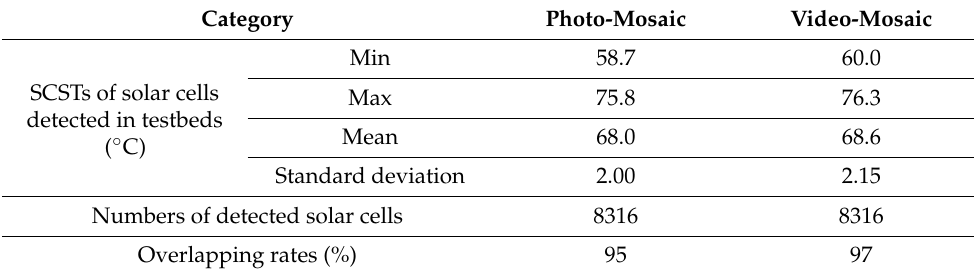
Table 2. Descriptive statistics of detected SCST ( ◦ C) in the photo-mosaic and